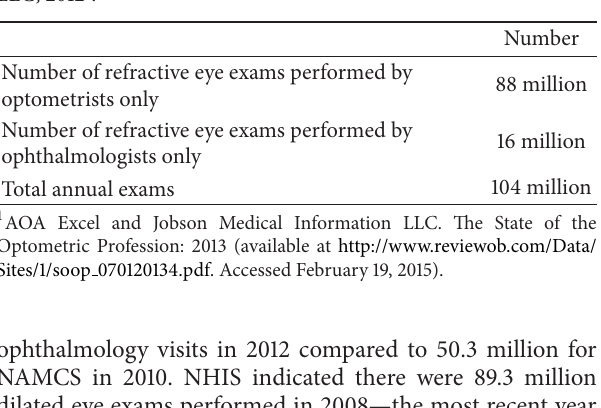
Table 3: Total number of refractive eye exams performed annually in the US reported by AOA Excel and Jobson Medical Information LLC, 2012 1